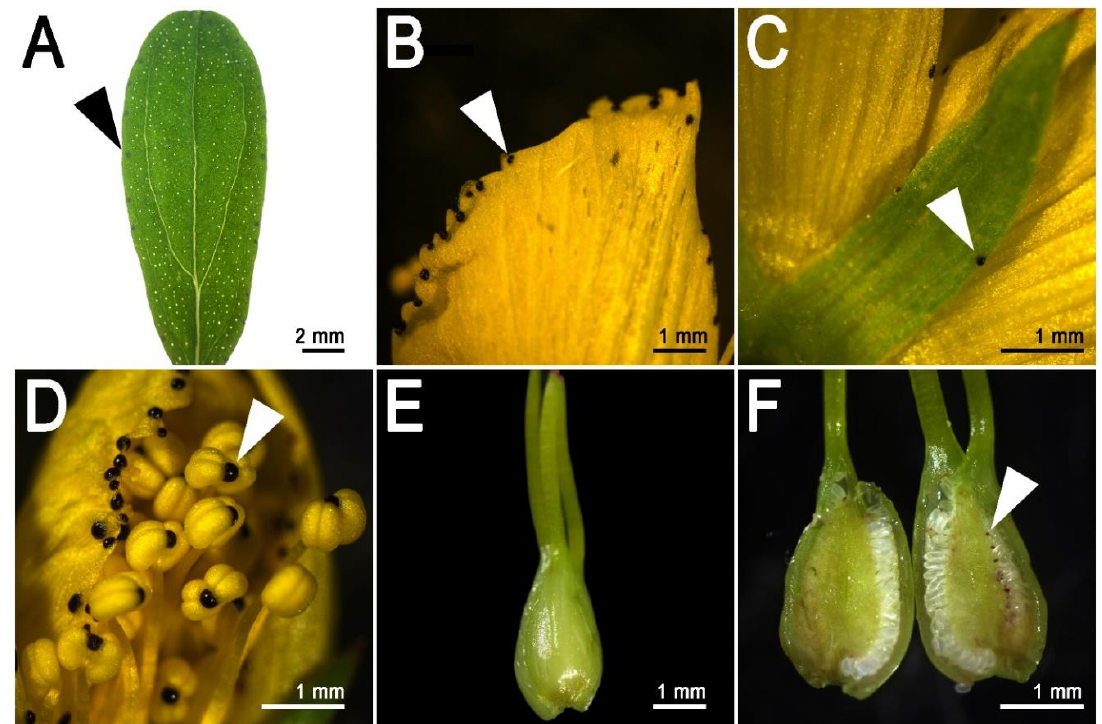
Figure 3 . Dark glands in different epigeal parts of Hypericum perforatum. ( A ): Adult leaf; ( B ): Dark glands on the petal rim; ( C ): Dark glands on the sepal rim; ( D ): Dark glands in the anthers; ( E ): Pistil external view, no dark glands visible; ( F ): Dark glands on the surface of the placental tissue. Short arrows indicate the dark glands. Photos by Paride